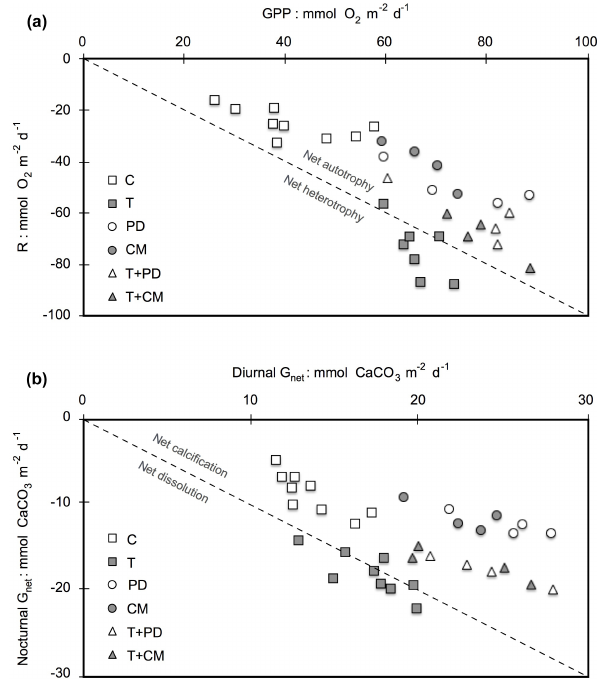
Figure 8. Measured metabolic rates from the control ( C ; n = 9) and warming ( T ; n = 7) treatments are displayed from all four incubations and the replicate chambers therein. Phytodetritus (PD), coral mucus (CM), and combination ( T + PD, T + CM) treatments are displayed from the two incubations (and repli- cate chambers therein) where each respective OM treatment was used ( n = 4). (a) Respiration ( R :mmolO 2 m − 2 d − 1 ) plotted as a function of gross primary production (GPP:mmolO 2 m − 2 d − 1 ) . Dashed line represents the divide between net heterotrophy and net autotrophy (GPP /R = 1). (b) Dark dissolution (dark G: mmolCaCO 3 m − 2 d − 1 ) plotted as a function of daytime calcifica- tion (diurnal G: mmolCaCO 3 m − 2 d − 1 ) . Dashed line represents the divide between net calcification and net dissolution ( G net =